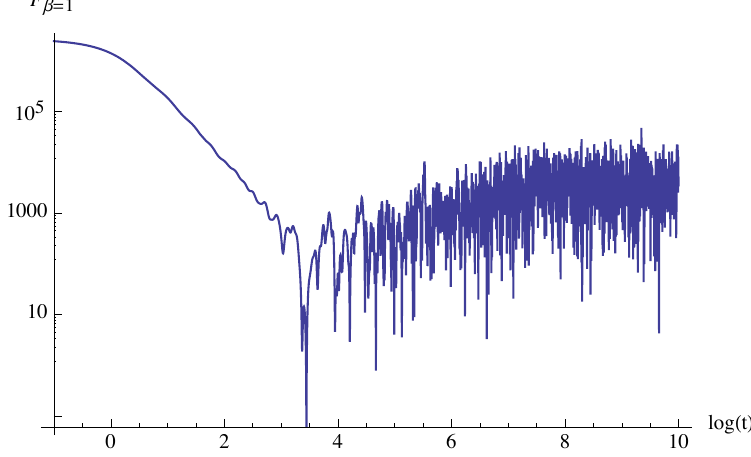
Figure 2 . Log-log plot of the spectral form factor (3.1) with (cid:12) = 1 for a single 1024 (cid:2) 1024 matrix drawn from the Gaussian Unitary Ensemble (GUE). The early part is self-averaging but the late part is superseded by